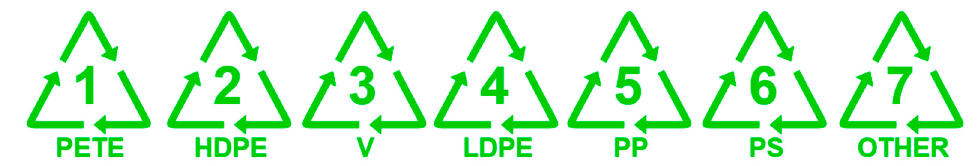
Figure 8. Designations for different groups of plastics in recycling according to [81].